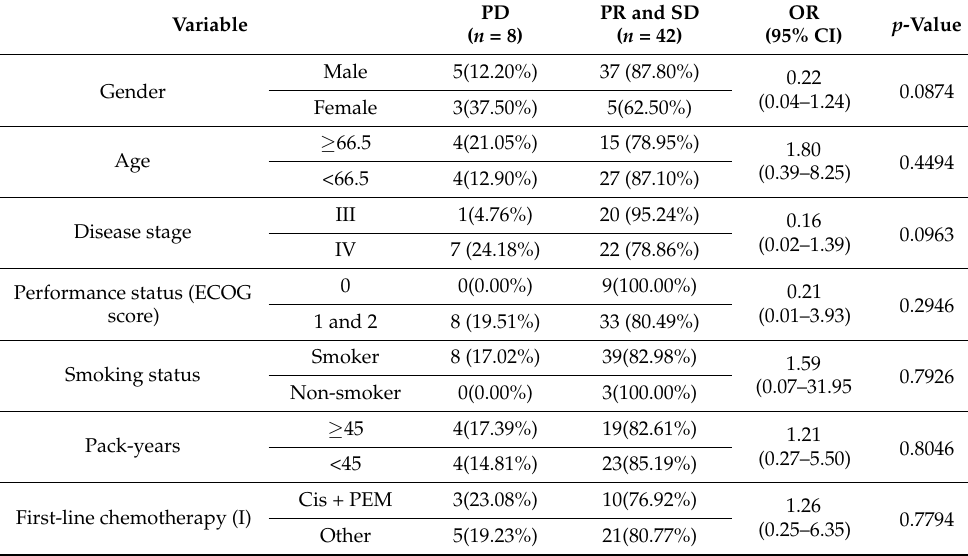
Table 4. Risk of disease progression according to demographic, clinical, and genetic factors (second